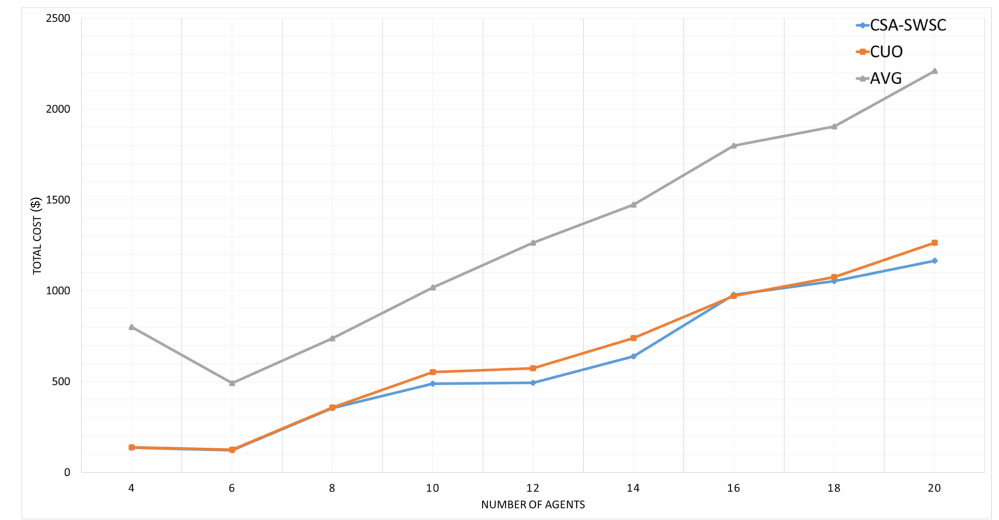
Figure 7. Variation in total cost of buyers with number of